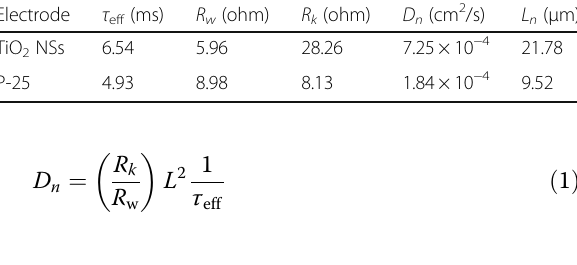
Table 3 EIS results of the TiO 2 NS- and P-25-based QDSSCs